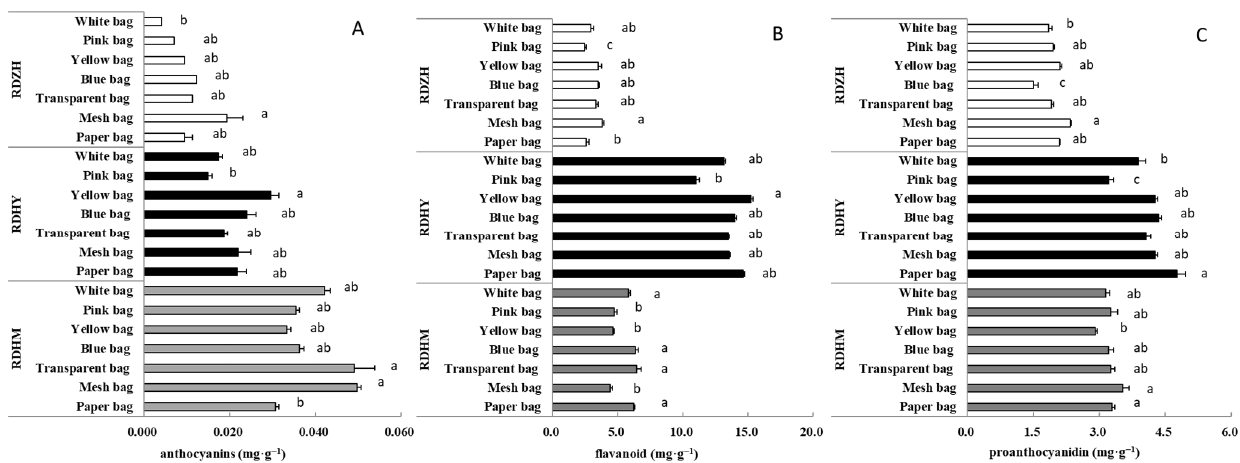
Figure 2. Effects of fruit bagging treatment with different types of bags on the total contents of anthocyanins ( A ), flavonoids ( B ), and proanthocyanidins ( C ) in the three table grape cultivars. Different letters besides the bars with the same color stand for the significant difference ( p value < 0.05).